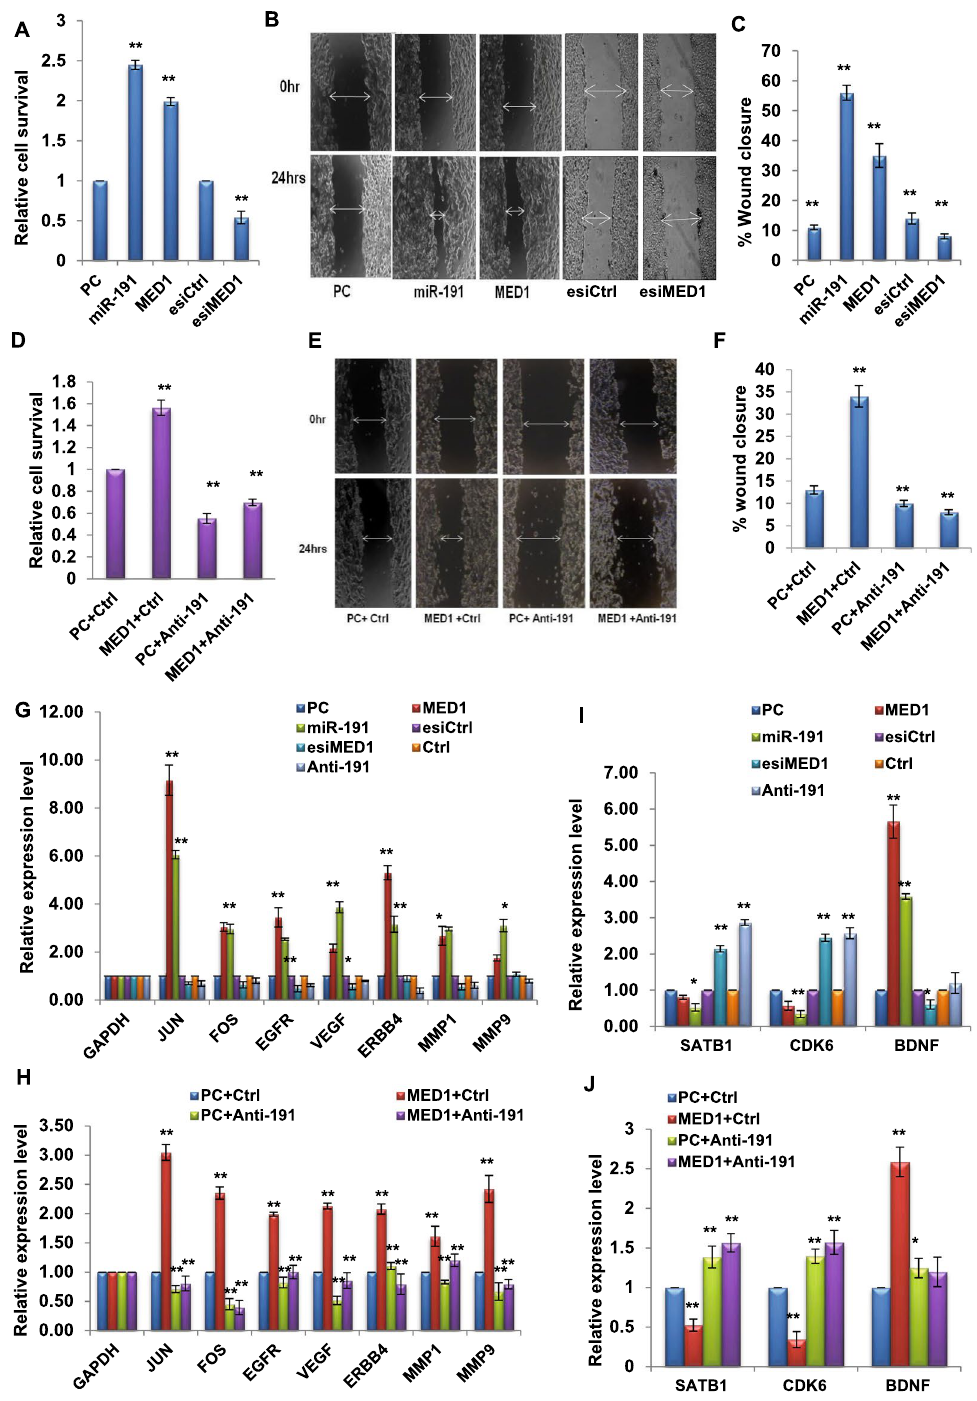
Figure 6. miR-191 acts as the downstream effecter of MED1 mediated cellular functions. ( A–C ) Functional implications of MED1 or miR-191 overexpression in breast cancer. MCF7 cells were transfected with MED1 or miR-191 or PC (control vector) and MTT assay was performed (48 hrs post transfection) to measure effect on cell survival. The results show that both MED1 and miR-191 promote cell survival ( A ). ( B , C ) Wound healing assay was performed to observe the effect of miR-191 and MED1 on cell migration. MCF7 cells were transfected with MED1 or miR-191 or control vector and gap or wound closure was observed ( B ) using Nikon microscope, 10X magnification and % gap closure was quantified using arbitrary scale ( C ). Graph shows that more healing (gap closure) was observed in response to both miR-191 and MED1 overexpression, hence both MED1 and miR- 191 impart enhanced cell migratory capacity to the cells. ( D–F ) MED1 mediated cellular effects are miR-191 dependent. MCF7 cells were transiently transfected with MED1/PC (vector control) along with inhibition of miR- 191(anti-miR-191)/Ctrl and effect on cell survival was looked for using MTT assay ( D ). Increase in cell survival due to MED1 overexpression was significantly reduced when miR-191 was inhibited along with MED1